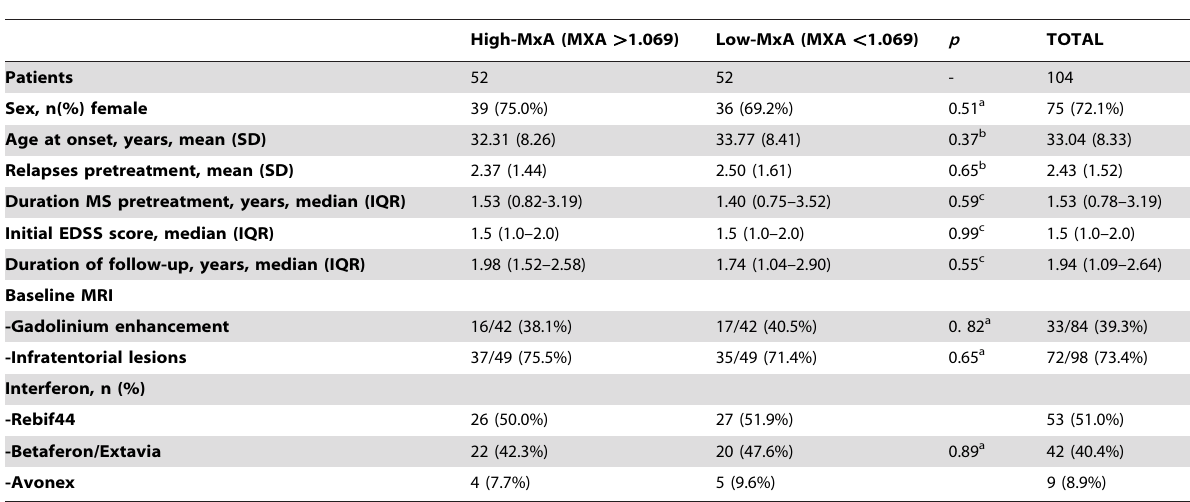
Table 1. Clinical and demographic baseline characteristics.